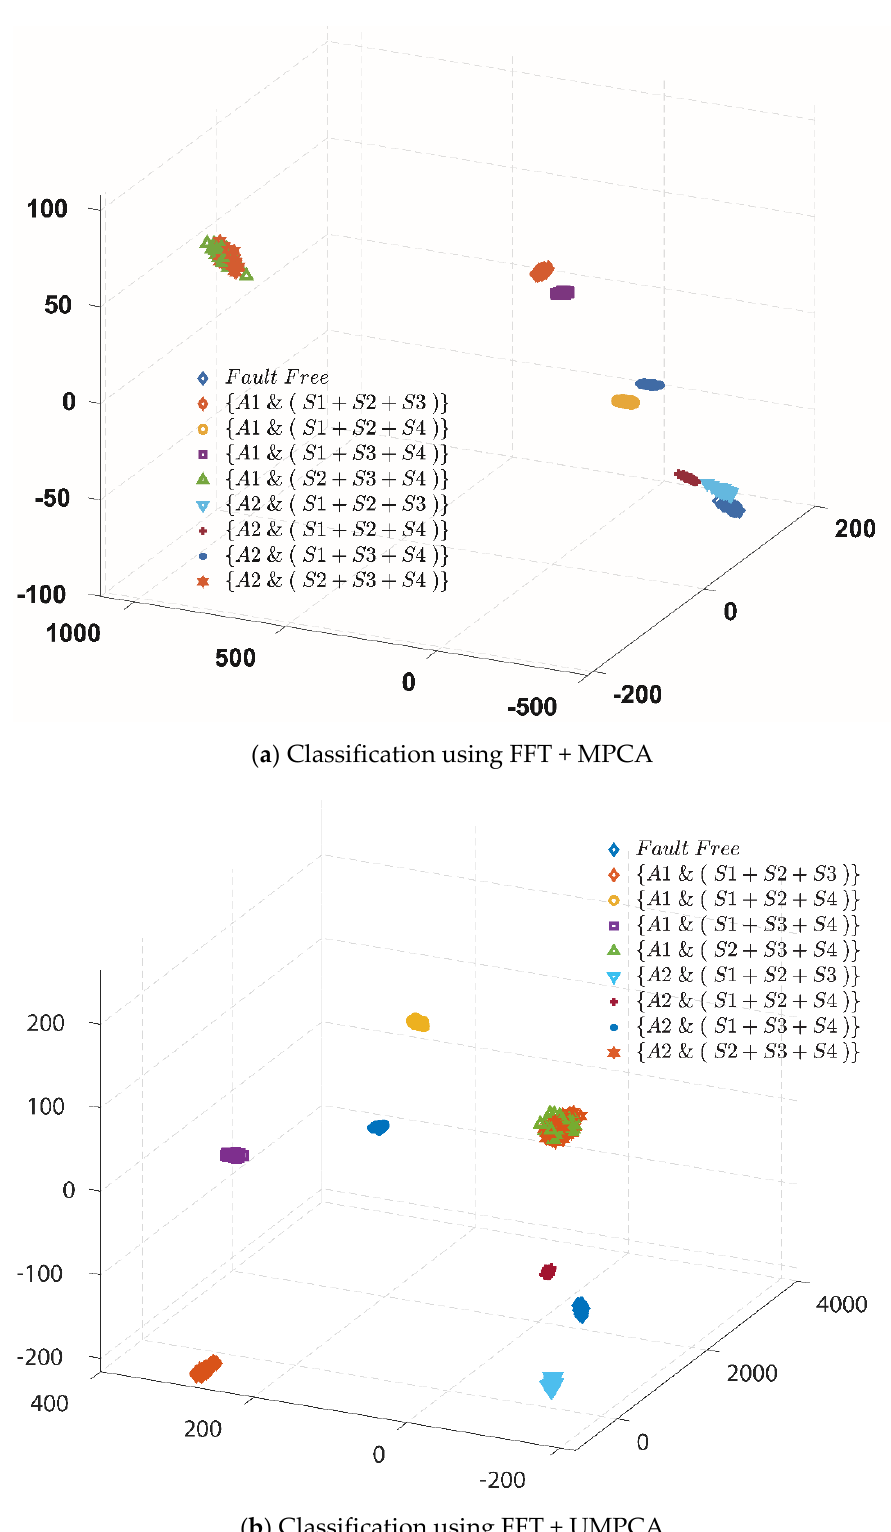
Figure 11. Three-dimensional space visualization performance for fault classification for wind turbines subjected to single actuator fault and three sensor faults under AWGN noises, using ( a ) FFT + MPCA and ( b ) FFT + UMPCA, respectively.